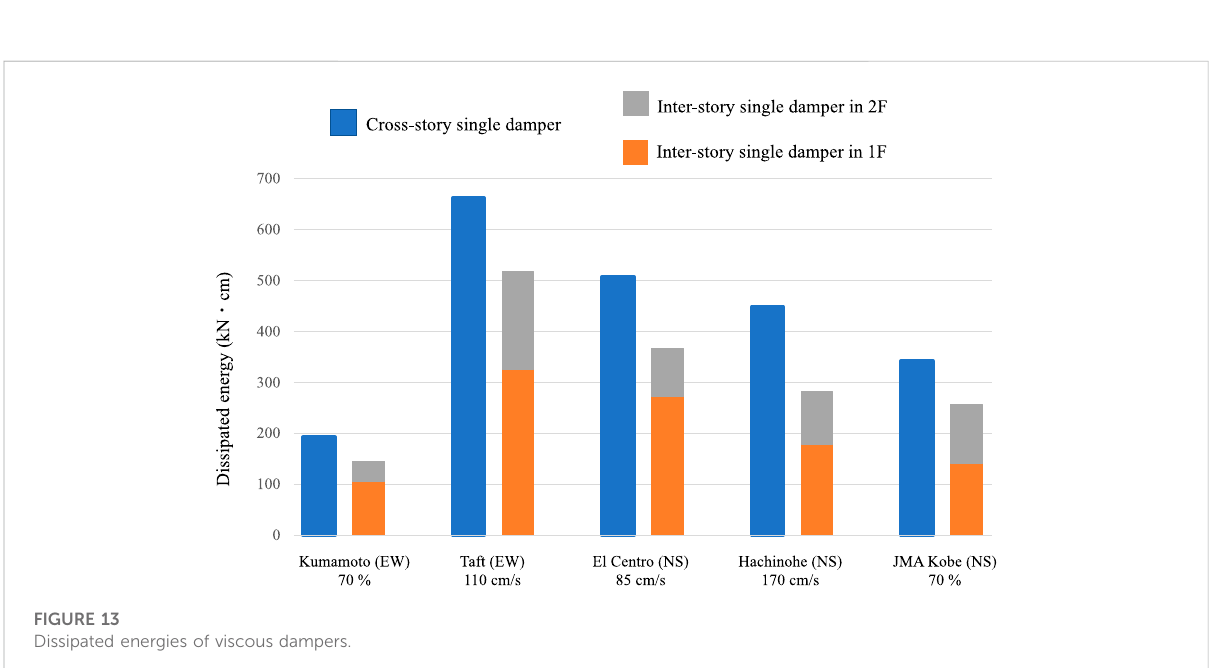
FIGURE 13 Dissipated energies of viscous